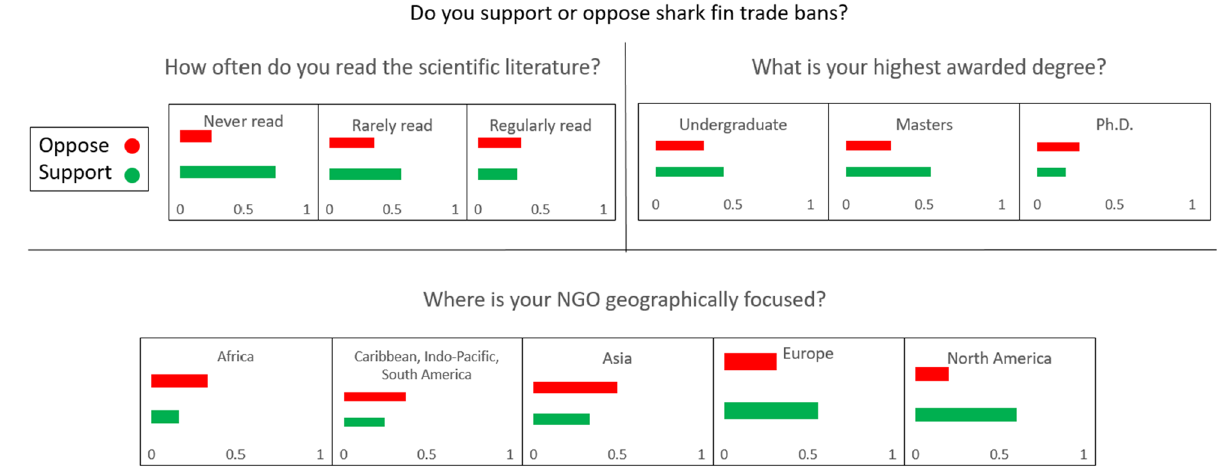
Figure 7. Proportion of respondents who support or oppose shark fin bans (neutral responses/no opinion removed), broken down by regularity of reading the literature, highest degree earned, and geographic area of